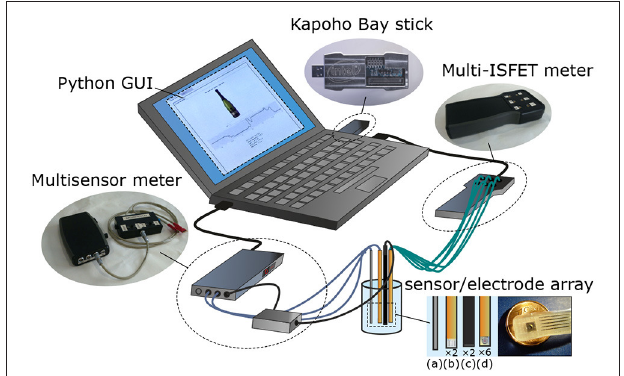
FIGURE 1 | Major components of the neuromorphic electronic tongue used in this work. Detail of sensors and electrodes: 1 microelectrodes (ORP and conductivity, b), 2 ISFET microsensors (d). Adapted from Margarit-Taulé et al. (2019).